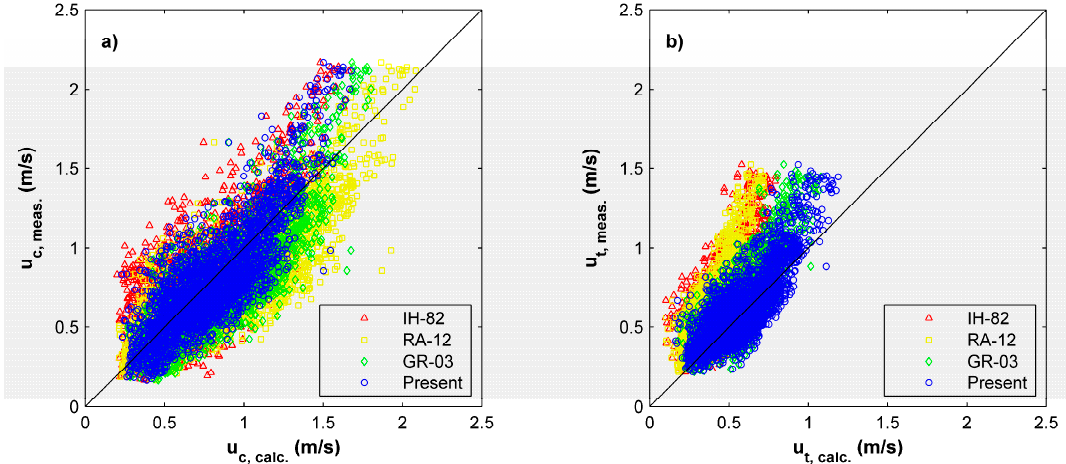
Figure 9. Comparison between computed peak onshore ( a ) and peak offshore ( b ) orbital velocity obtained by the studied formulas and measurements for Egmond Beach.